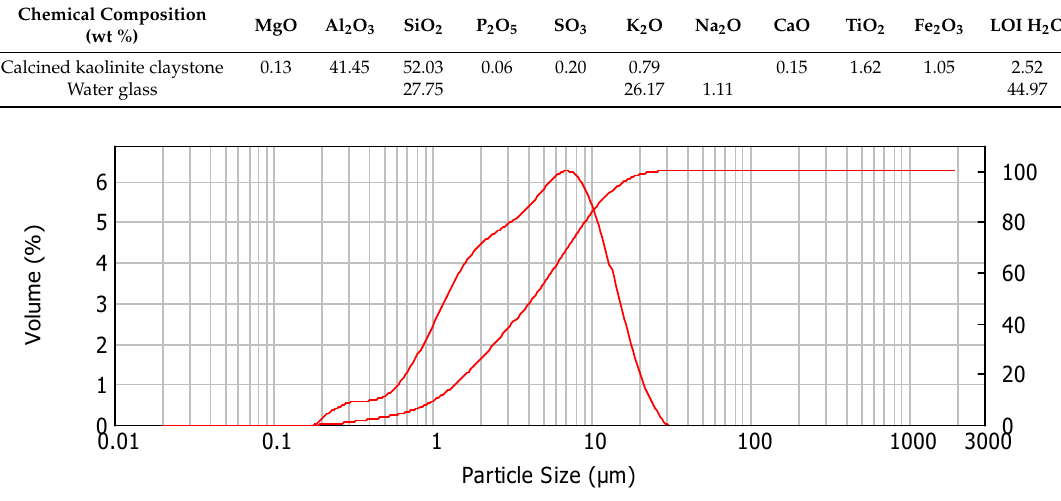
Republic (grain 0.063–0.40 mm, median-diameter 0.14 mm) was used as a reinforcement [28].